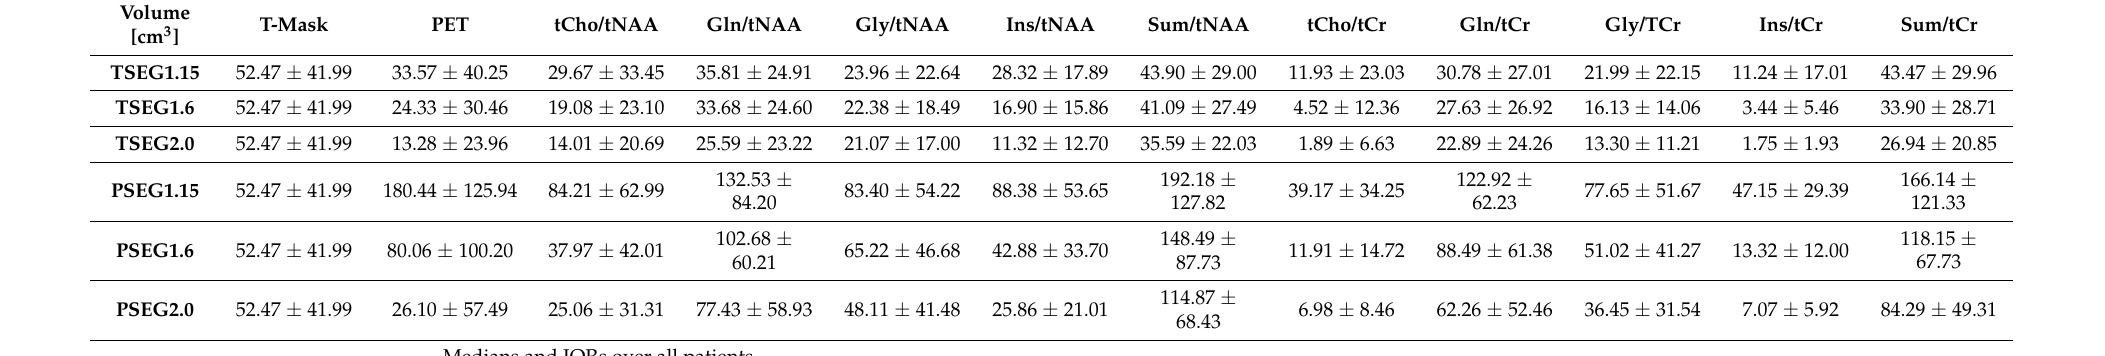
Table 5. VOI volumes for all ratios and VOI thresholds.